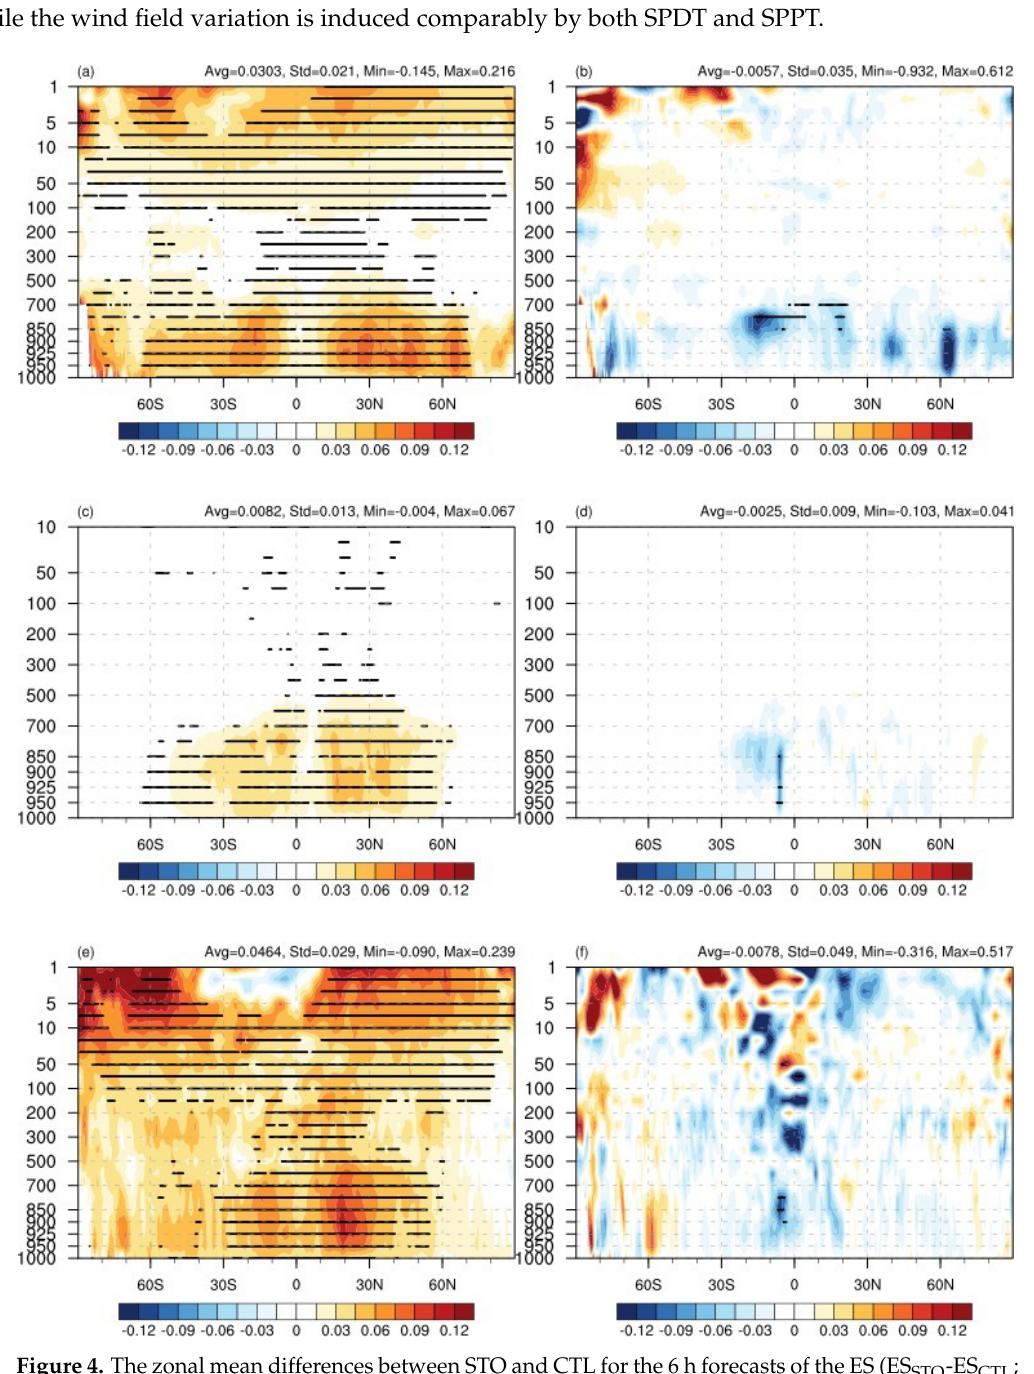
Figure 4. The zonal mean differences between STO and CTL for the 6 h forecasts of the ES (ES STO -ES CTL ; left panels) and the EME (EME STO -EME CTL ; right panels) against the IFS analysis: ( a , c ) temperature (in K), ( b , d ) specific humidity (in g kg − 1 ), and ( e , f ) zonal wind (in m s − 1 ). Results are represented with a composite of the 49 cycles’ background fields from 18:00 UTC on 25 June to 18:00 UTC on 7 July 2018. Dots indicate the composite differences with the 99% statistical significance based on the two-tail t